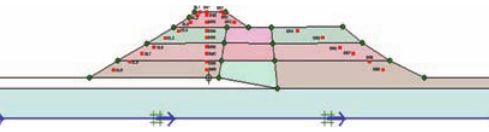
Figure 9: Location of stress points for Upper San Fernando dam.